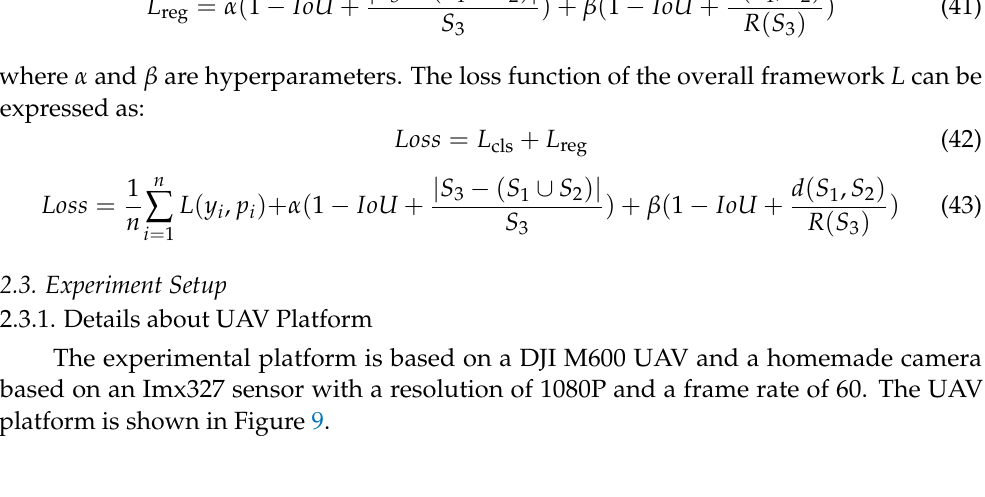
where d ( S 1 , S 2 ) denotes the distance between the centroids of the two boxes and R is the diagonal S 3 . Thus, the regression loss function L reg based on MIoU is a combination of DIoU of GIoU